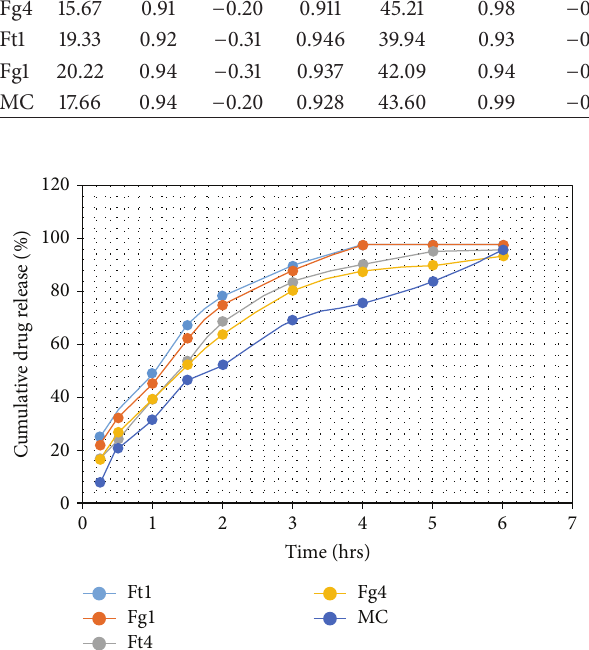
Figure 2: In vitro % drug release versus time plot of different